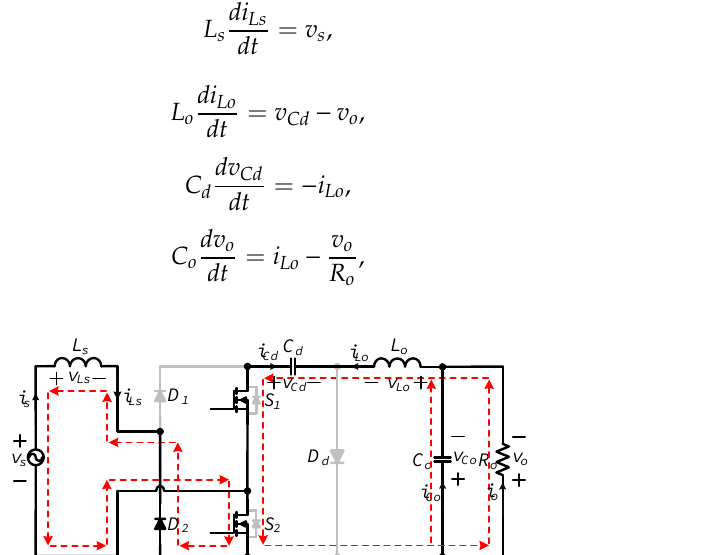
Figure 8. Equivalent bridgeless Cuk converter circuit in State 1 during negative half line cycle.